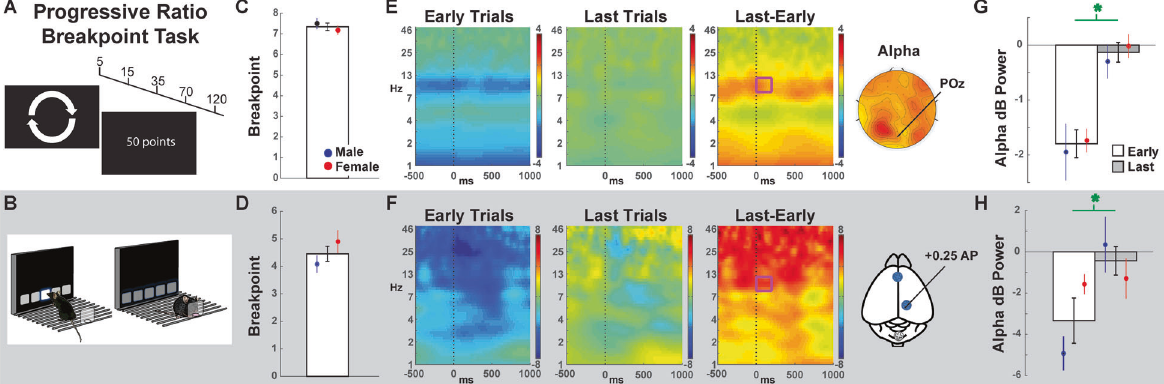
Fig. 2 The progressive ratio breakpoint task (PRBT) required the subject to continuously engage in behavior with a diminishing probability of reward. A In humans, participants had to rotate a joystick an increasing number of times (e.g. 5, 15, 35 … ) to accumulate rewards. B Mice touched the screen an increasing number of times for the magazine to dispense liquid reward. C – D Breakpoints for each species including means split by sex. E – F Time-frequency plots of the earliest vs. the last trials at POz in humans or the posterior lead in mice. For the sake of effective visual comparison, the time dimension is − 500 to 1000 locked to markers placed every second (for humans) or every trial (for mice). The magenta box shows the alpha-band tf-ROI. Since the baseline for both species was spread across all trials, all power values are relative (thus “ negative ” in early trials). G – H EEG tf-ROI quanti fi cation of the early vs. last difference in posterior alpha. Bars indicate the group means (± SEM), green asterisks indicate statistically signi fi cant ( p < 0.05) within-subject